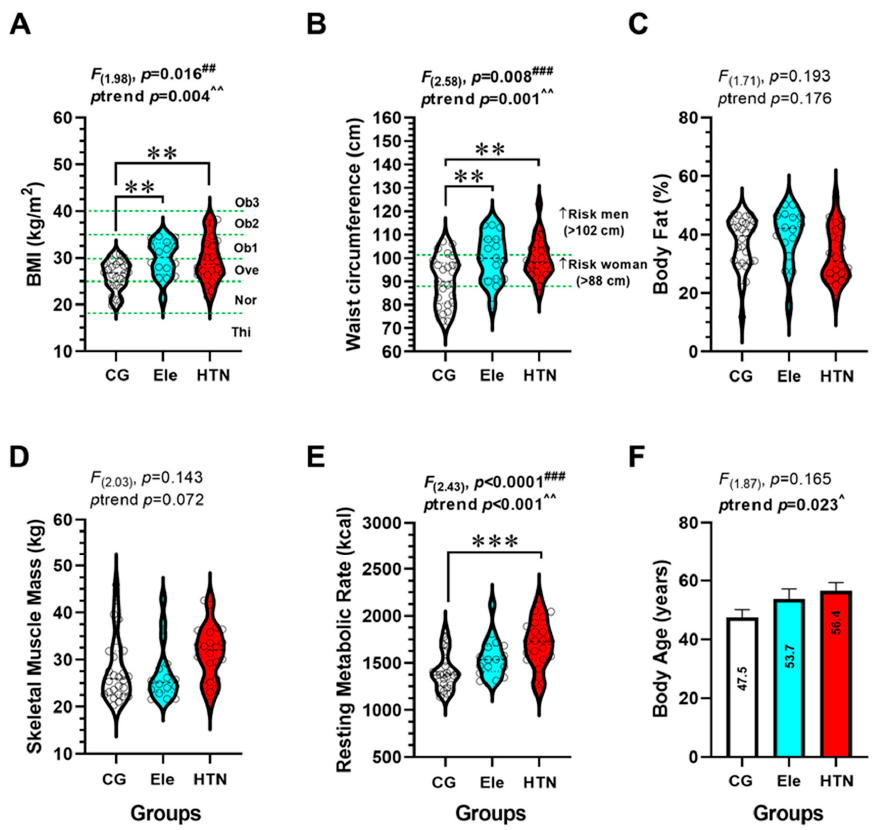
Figure 3. Anthropometric (body mass index (panel A ), waist circumference (panel B )), and body composition outcomes (body fat % (panel C ), skeletal muscle mass (panel D ), resting metabolic rate (panel E )), and body age estimated (panel F ) in three groups of adults with different blood pressure levels. The groups are described as: (CG) Control normotensive group, (Ele) Elevated blood pressure, and (HTN) arterial hypertension group. A green intermittent line denotes different adiposity and categorization cut-off points to BMI. Bold values denote significant modifications. (**) Denotes significant differences among groups at p < 0.001. (***) Denotes significant differences among groups at p < 0.0001. (##) Denotes interaction by ANOVA p < 0.001. (###) Denotes interaction by ANOVA p < 0.0001. (^) Denotes a significant trend across groups at p < 0.05. (^^) Denotes a significant trend across groups at p < 0.001.